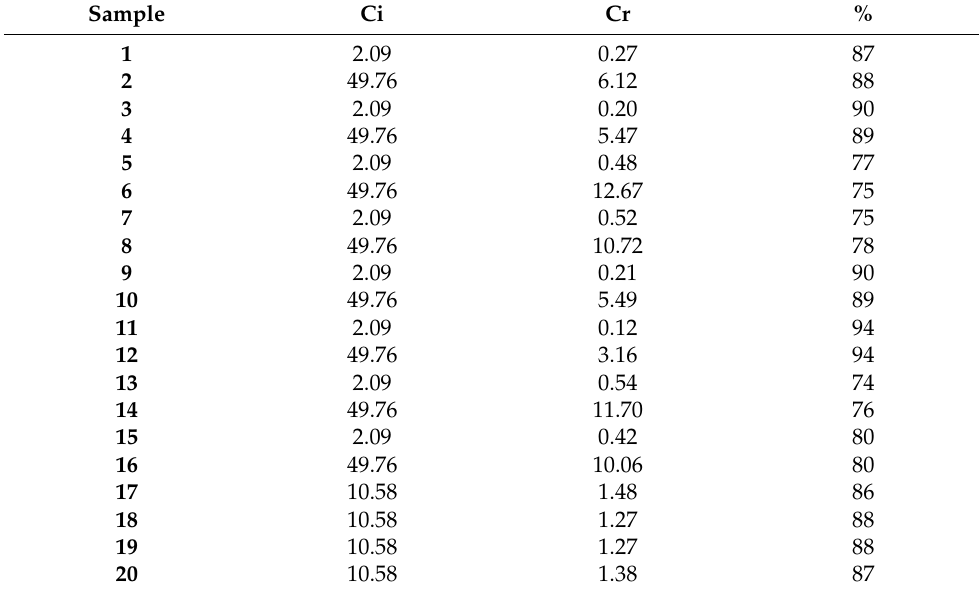
Table 3. Disulfoton compound degradation rate (%).